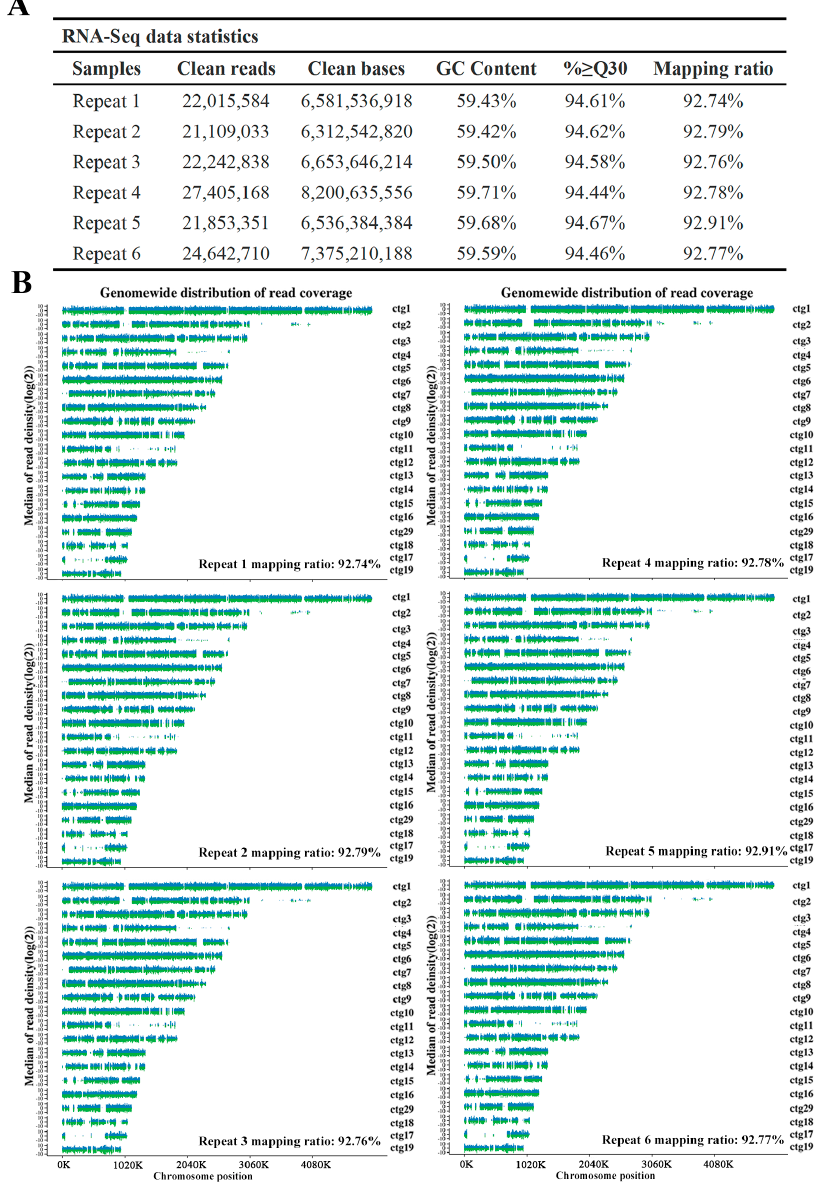
Figure 5. Summary of transcriptome sequencing data. ( A ) The statistics of RNA sequencing data. ≥ Q30%: Percentage of bases with a Q-score no less than Q30. ( B ) Distribution of mapped reads